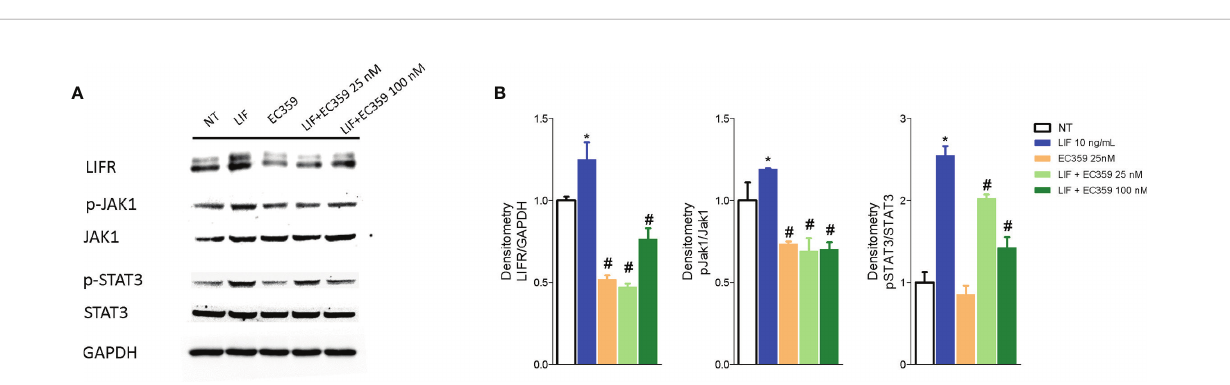
FIGURE 6 | LIFR antagonist EC359 hinders cell cycle progression, increases apoptosis rate in MKN45 cells and inhibits EMT process. (A) Dose – response curve of EC359 (25, 50, 100, and 1,000 nM) determined using MTS assay on MKN45 cells (n = 10). MKN45 cells were serum-starved and triggered with LIF (10 ng/ml), EC359 (100 nM), and LIF + EC359 for 48 h. Cell cycle phase analysis was performed by Ki-67/DAPI staining through IC-FACS. Data shown are follows: percentage of (B) from left to right cell in G0-G1 cell cycle phases, S-G2-M cell cycle phases, and ratio between % G0-G1 and % S-G2-M. (C) Percentage of apoptotic cells. (D) Representative IC-FACS showed cell cycle fraction and apoptosis rate in NT, LIF (10 ng/ml), EC359 (25 nM), and LIF + EC359. Results are the mean±SEM of three samples for group (* represents statistical signi fi cance versus NT, and # versus LIF, p<0.05). Relative mRNA expression of (E) the proliferation marker C-Myc and EMT markers (F) E-Cadherin, (G) Snal-1, and (H) vimentin. Each value is normalized to Gapdh and is expressed relative to those of positive controls, which are arbitrarily settled to 1. Results are the mean±SEM of fi ve samples per group (* represents statistical signi fi cance versus NT, and # versus LIF, p<0.05).